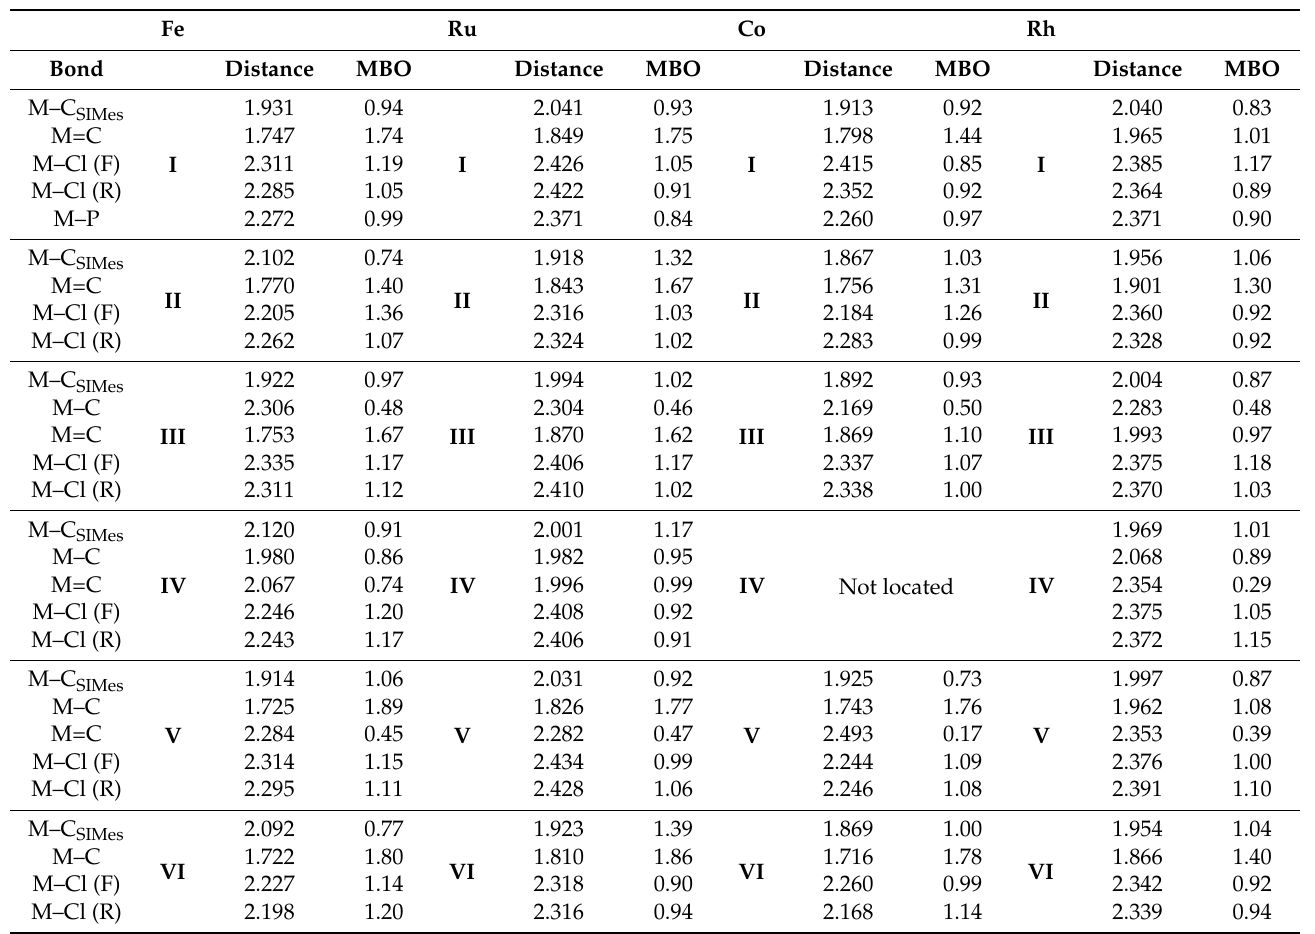
Table 3. Bond lengths (in Å) and Mayer Bond Orders (MBOs) for all the molecules involved in the mechanism for the Fe, Ru, Co, and Rh transition metals. (F = front and R = rear position of the chlorides according to the orientation in Figure 1, and the labeling Ru=C and Ru–C is maintained throughout the whole reaction pathway for the sake of